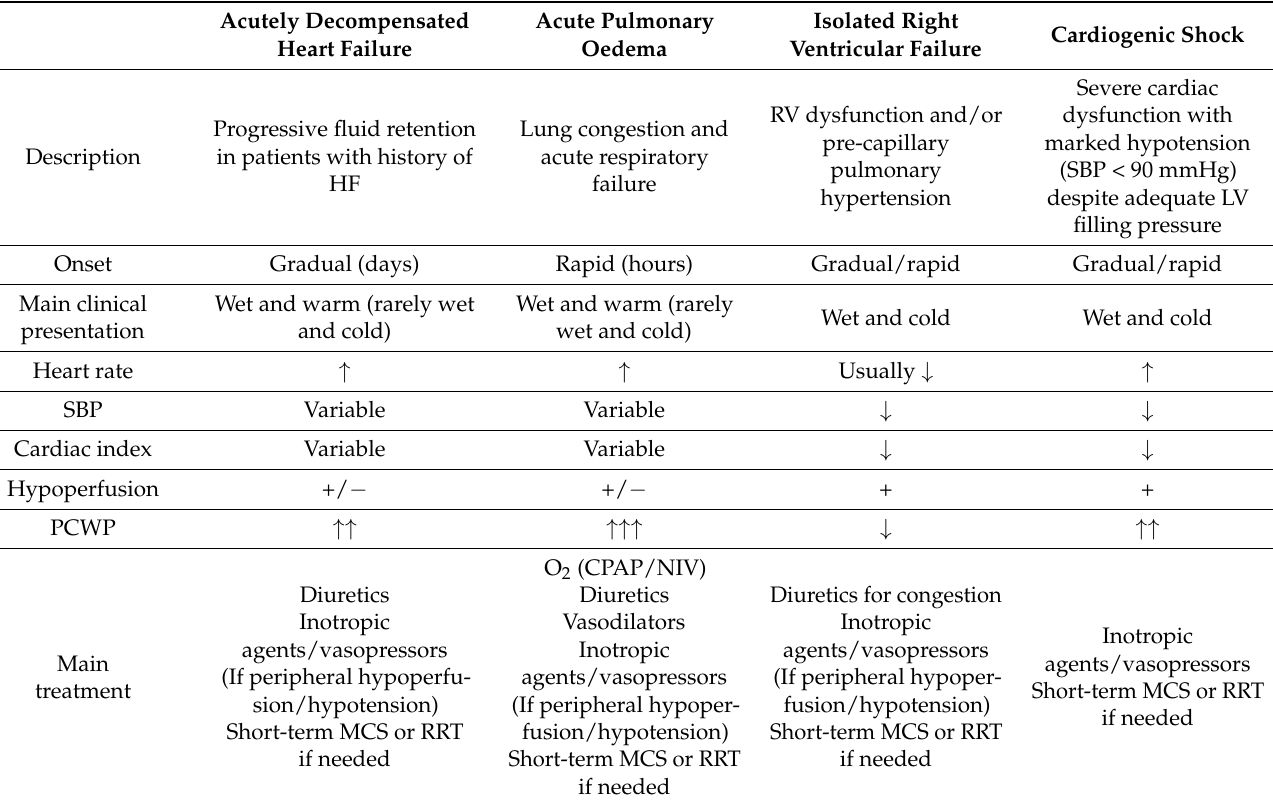
Table 1. Classification of